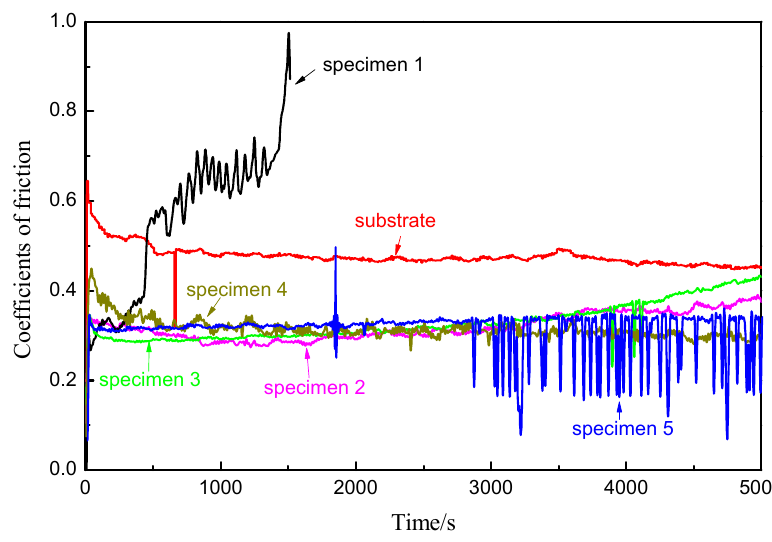
Figure 4. The friction coe ffi cients of di ff erent specimens.